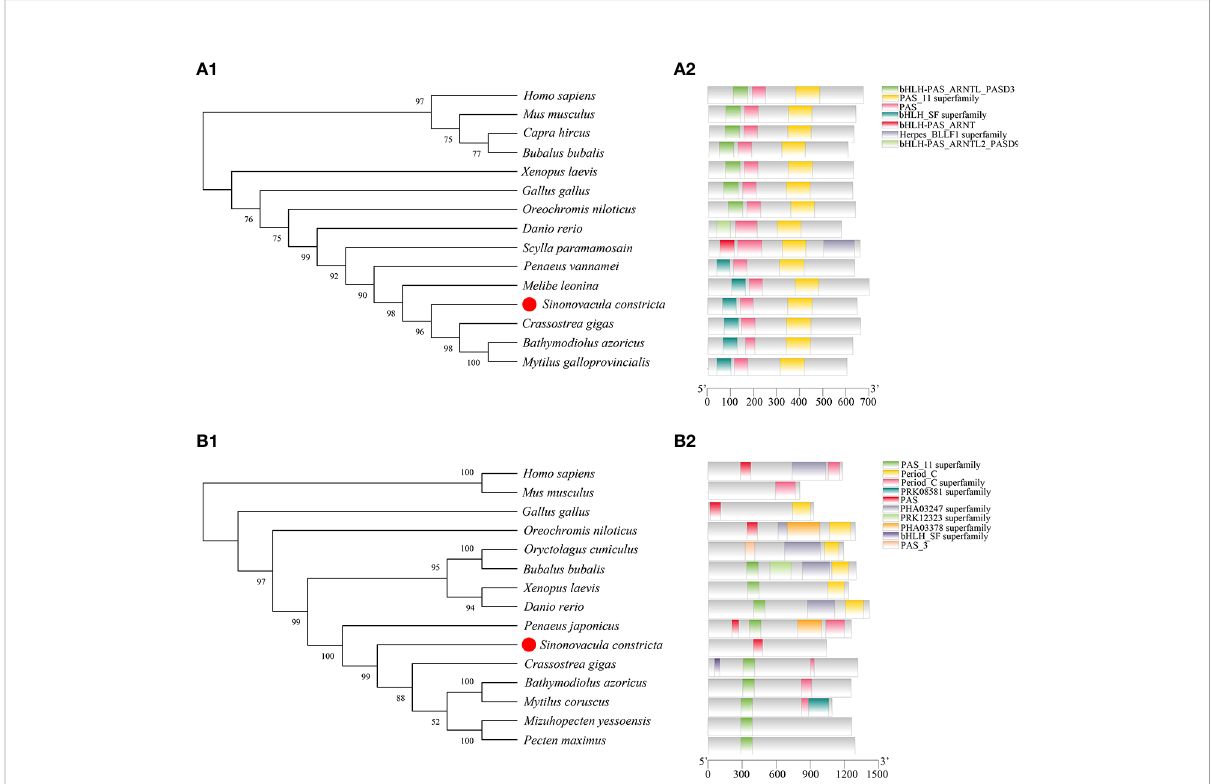
FIGURE 2 Bioinformatics analysis of Bmal1 (A) and Period (B) in S . constricta . (A1 and B1) Phylogenetic trees of Bmal1 (A1) and Period (B1) constructed from S . constricta and other species with the maximum likelihood method (Bmal1: JTT+F+G model, Period: JTT+F+G+I model). (A2 and B2) The functional domain analysis of Bmal1 (A2) and Period (B2)